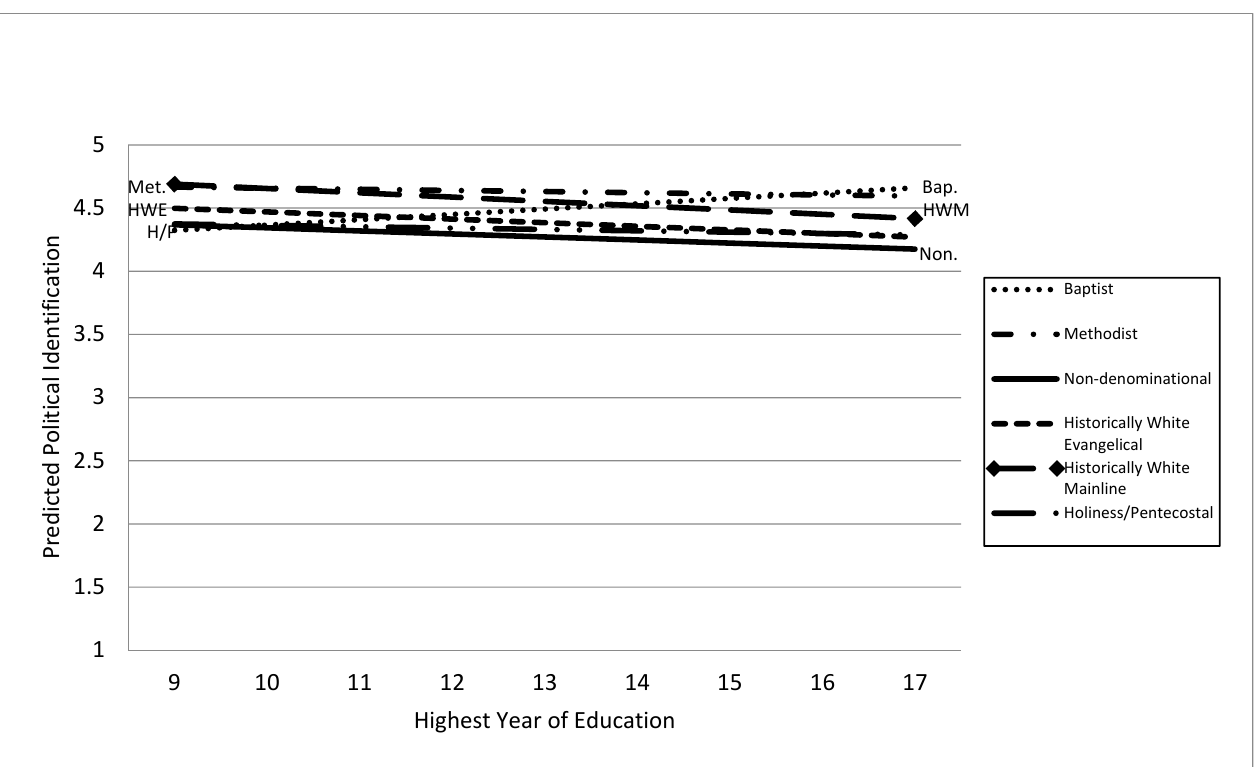
Figure A7. Black Protestant party identification by religion and education, Pew 2014 Religious Landscape Survey.